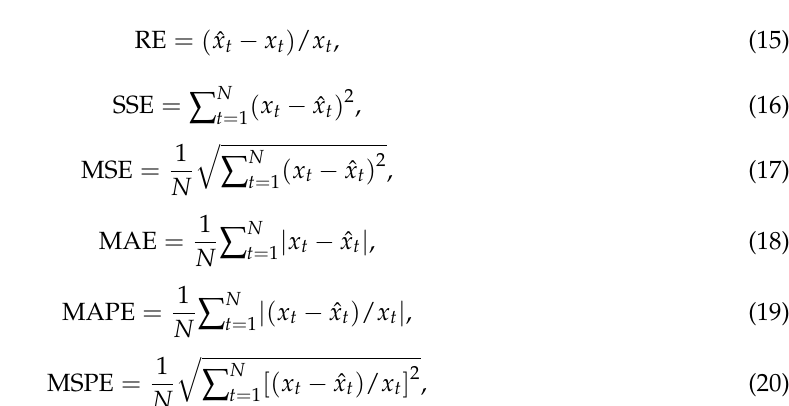
(MAPE) and mean square percent error (MSPE):